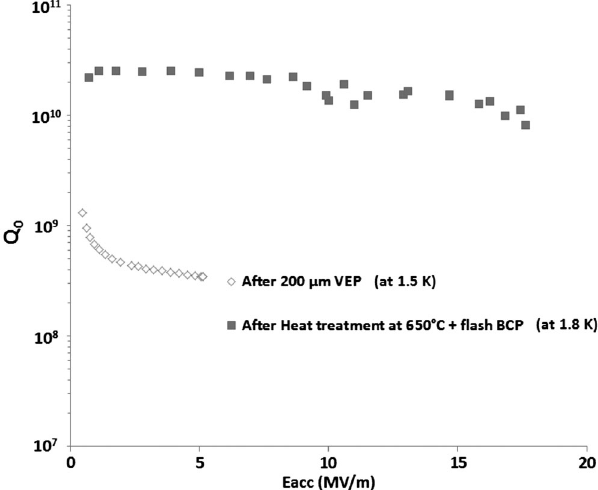
FIG. 16. Tests of the SPL cavity in vertical cryostat before and after heat treatment. The heat treatment at 650 ° C efficiently cured the hydrogen contamination. The test was stopped at 18 MV = m because of the too high radiation level (field emission onset at 10 MV = m). An additional test is planned at higher gradients.